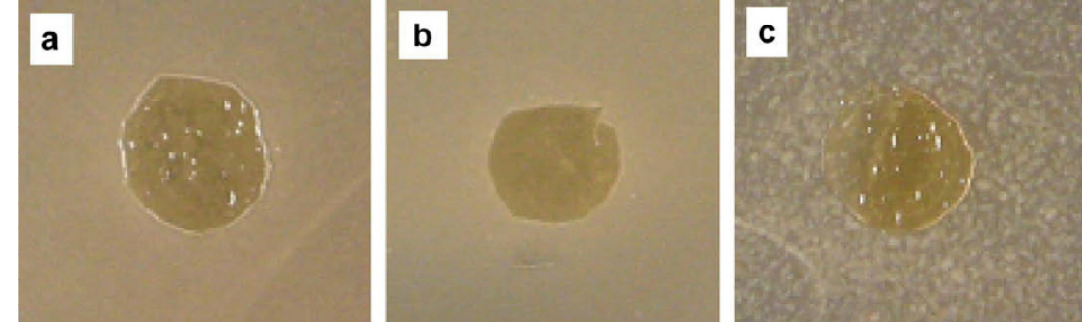
Fig. 2. Extraction process of chitin and chitosan [65]. 5